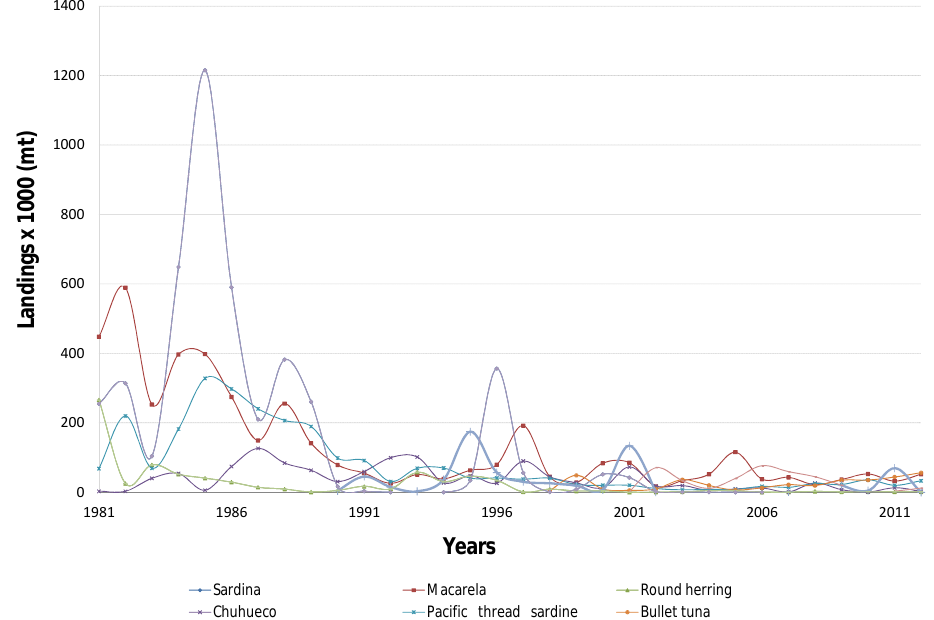
Figure 2. Total landings of pelagic fish (1981–2012) registered by the Ecuadorian fleet. Sardine (sardinas), chub mackerel (macarela), round